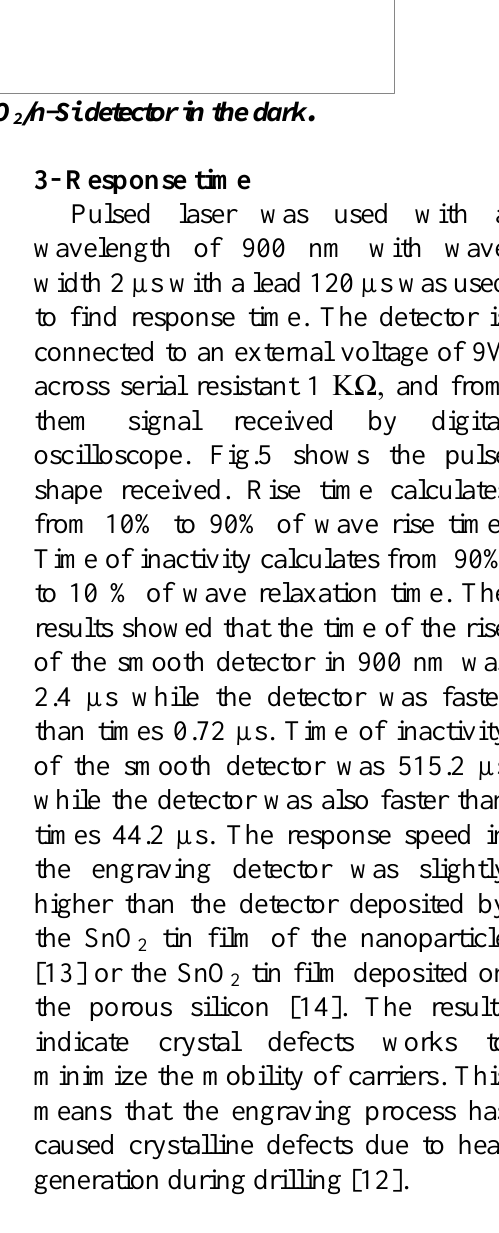
Fig.3: (I-V) characters of SnO